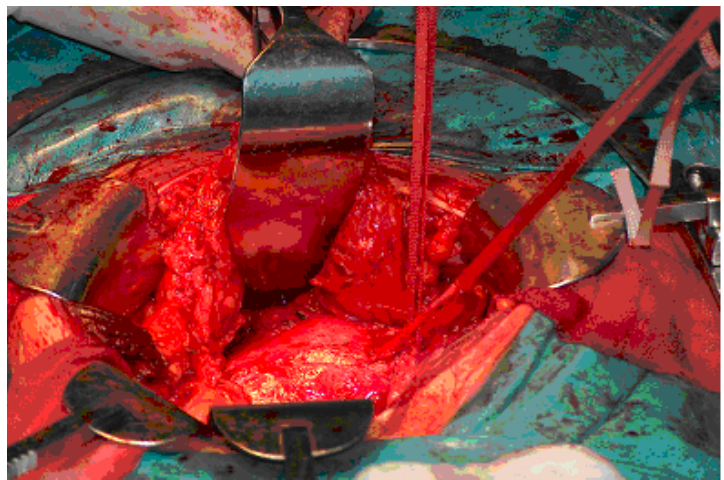
FIGURE 3 . Eleveated right ductus deferens above cyst.